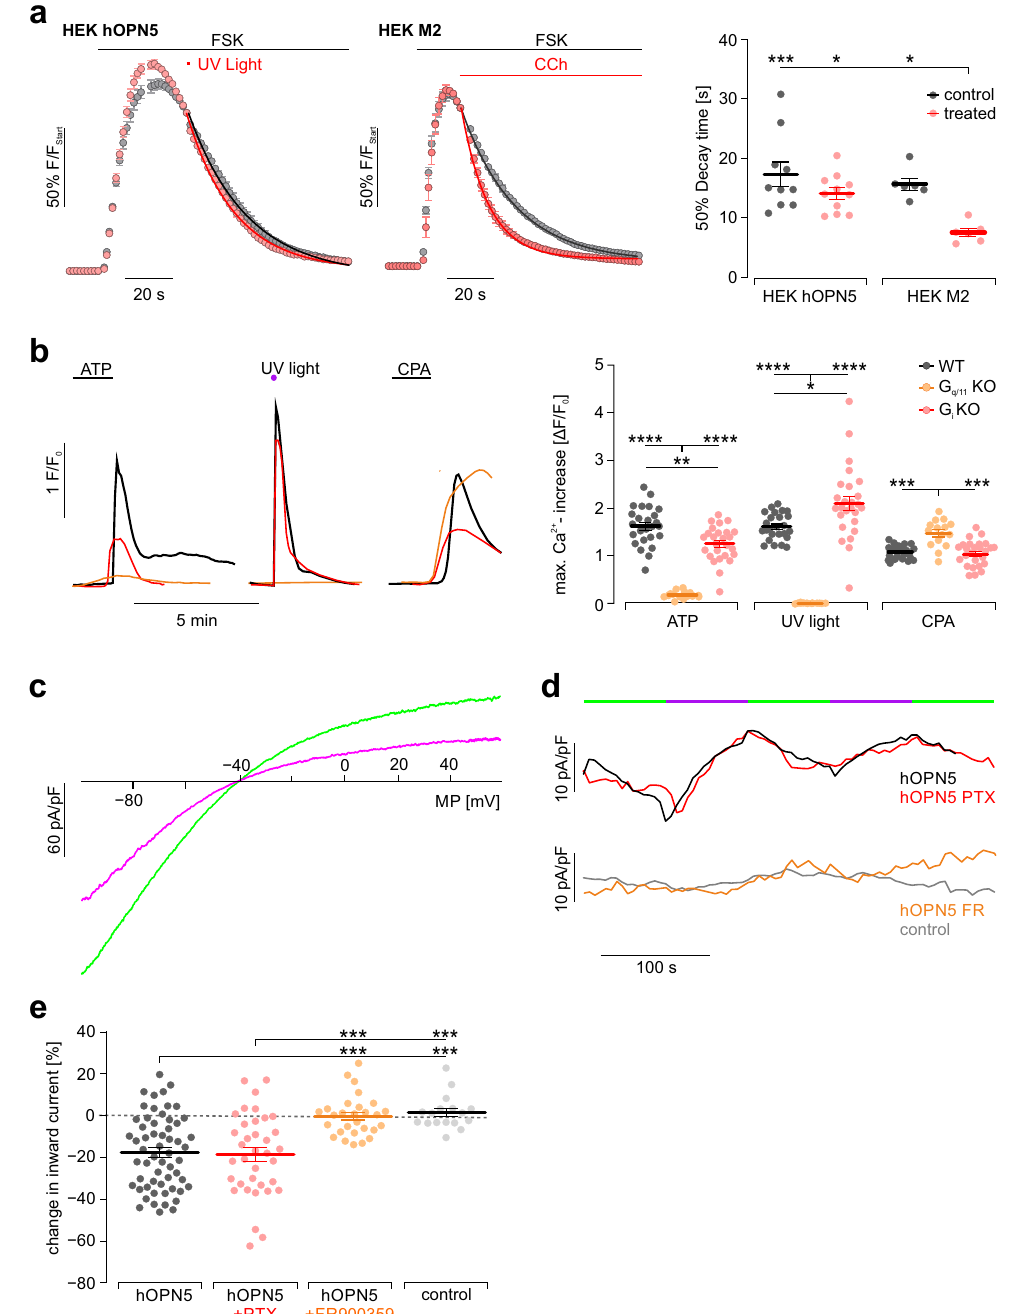
Fig. 3 hOPN5 does not activate G i proteins in HEK cells. a Averaged time courses (left, average of 10, 11, and 6 individual wells for hOPN5 and M2, respectively) of cAMP levels analysed by GloSensor luminescence after adenylate cyclase stimulation with Forskolin (10 µ M, FSK) and normalized to application of UV light (F Start, 500ms, 110 µ W/mm 2 ) or CCh (100 µ M) in HEK cells expressing hOPN5 or the muscarine ACh receptor 2 (M2). Statistical analysis (right) of 50% decay time analyzed by exponential fi t of each well individually (each dot represents one well) with ordinary one-way ANOVA with Tukey ’ s multiple comparison test (p(hOPN5 control vs. hOPN5 light): 0.32; p(hOPN5 control vs. M2 control): 0.87; p(M2 control vs. M2 CCh): 0.012; p(hOPN5 light vs. M2 CCh): 0.024). b Representative traces (left) and aggregated data (right) of Ca 2 + transients induced by 1.5mM ATP, UV light (1mW/mm 2 , 1s) and 50 µ M cyclopiazonic acid (CPA) in HEK WT cells (black), in HEK G i KO cells (red) and in HEK G q/11 KO cells (orange). Statistical analysis with a two-way ANOVA repeated measurements test. Indicated p values are from a Tukey ’ s multiple comparison test for the varying effects of the stimulations ( N = 15 for G q/11 KO cells, N = 26 for G i KO cells, and N = 25 for HEK WT cells; p = 0.76 for HEK WT versus G i KO cells in CPA treatment). c Representative current-voltage ramps (outward currents in positive direction) of hOPN5/GIRK HEK cells during UV (385nm, 1mW/mm 2 , 75s, violet) and green (500 – 600nm, 14mW/mm 2 , 75s, green) illumination. d Time course of inward currents (in negative direction) at − 80mV during UV (violet bars) and green illumination (green bars). e UV light induced change in inward current at − 80mV (each dot represents one individual cell) in control and hOPN5 cells without and with PTX or FR900359 treatment. Statistics with a non-parametric ANOVA test with Tukey ’ s multiple comparison post-test. p(hOPN5 vs hOPN5 PTX) = 0.99; p(hOPN5 FR vs control) = 0.99. Data are presented as mean values ±SEM. * p < 0.05, ** p < 0.01, *** p < 0.001. **** p <